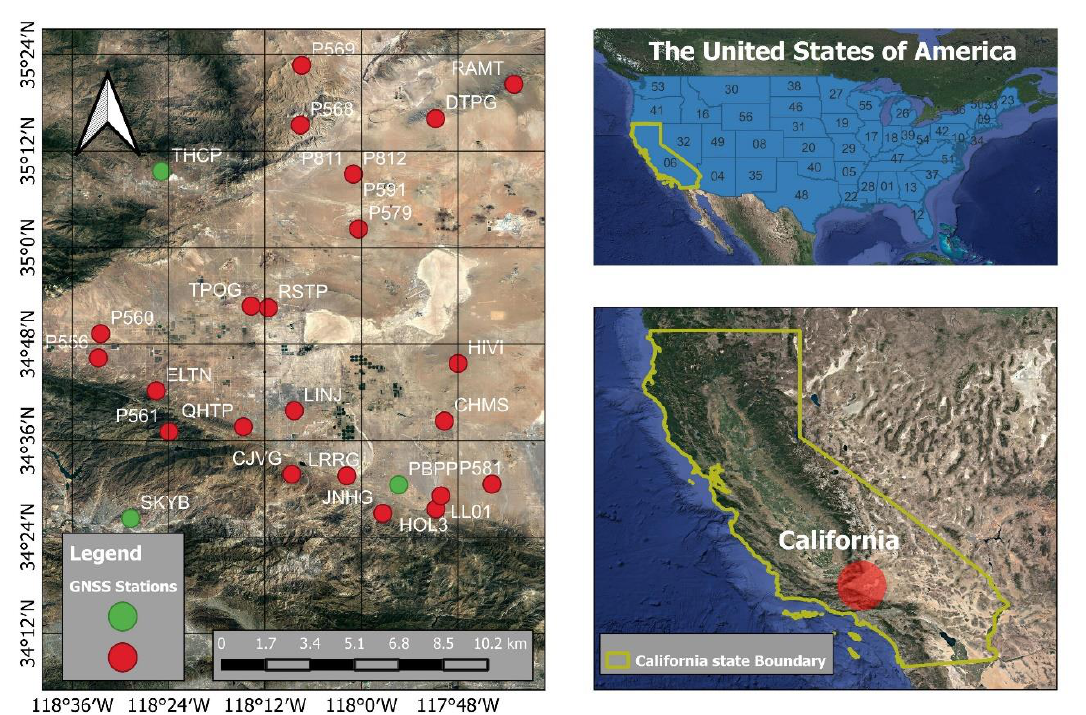
Figure 1 . Study area and distribution of GNSS